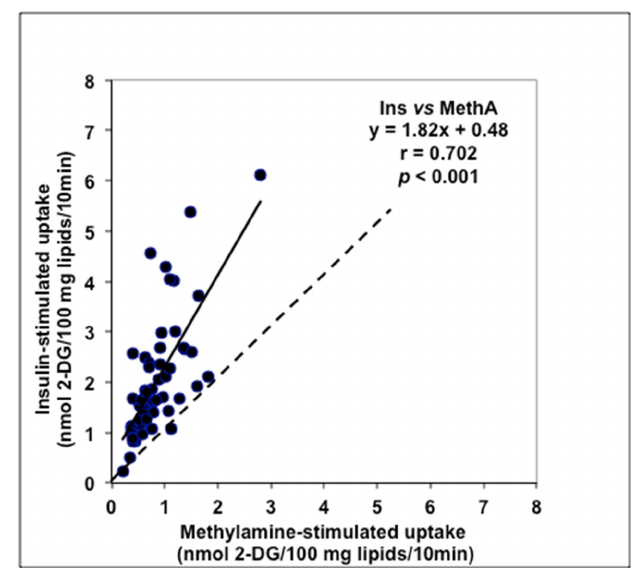
Figure 4. Relationships between insulin (Ins) and methylamine (MethA) stimulation of glucose transport in adipocytes isolated from abdominal ScAT. Dotted line represents identity line for the two variables. Linear regression equation (black line) and p value refer to 56 individuals, showing mean ± SEM values of 2-DG uptake of 2.03 ± 0.16 and 0.85 ± 0.06 nmol / 100 mg lipids / 10min for 100 nM insulin and 1 mM methylamine,